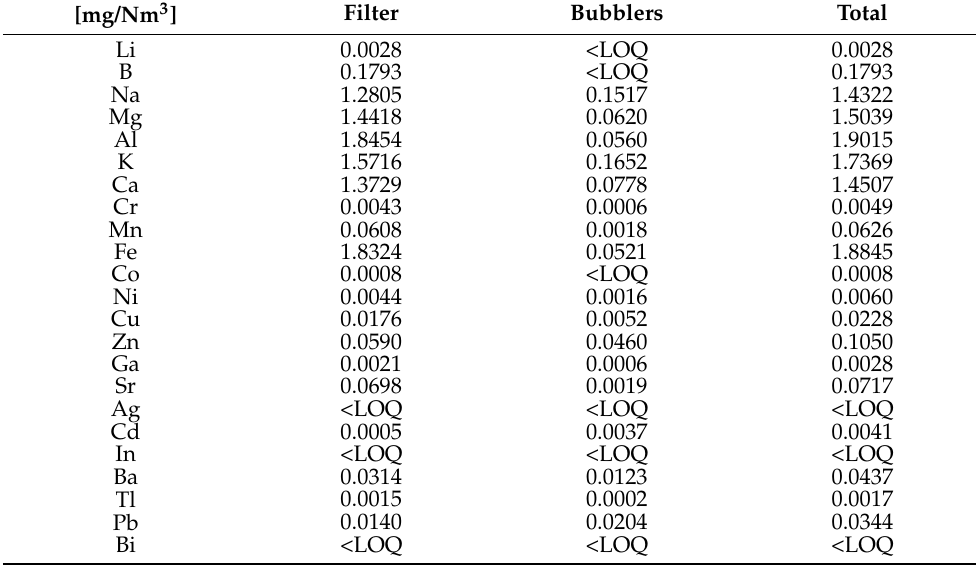
Table 8. Distribution of metals emission between filter and volatile phase